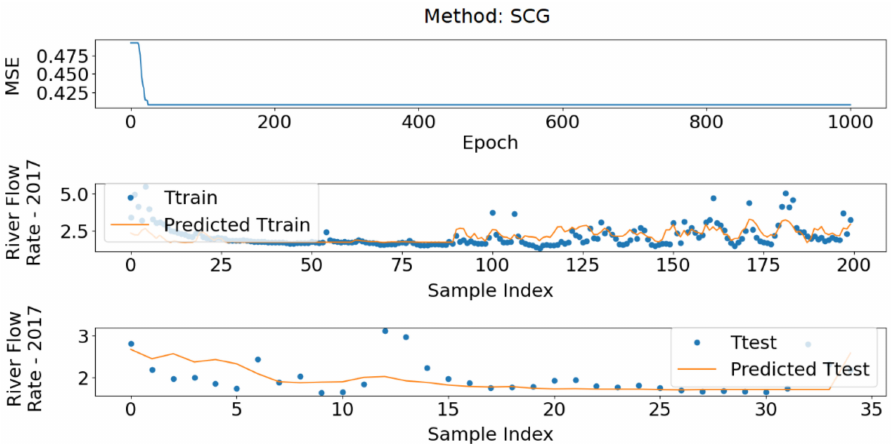
Figure 2. Machine learning results. The upper panel shows the error function over the training generations, the middle panel compares the predicted output with the training data, and the lower panel tests data with the predicted data.